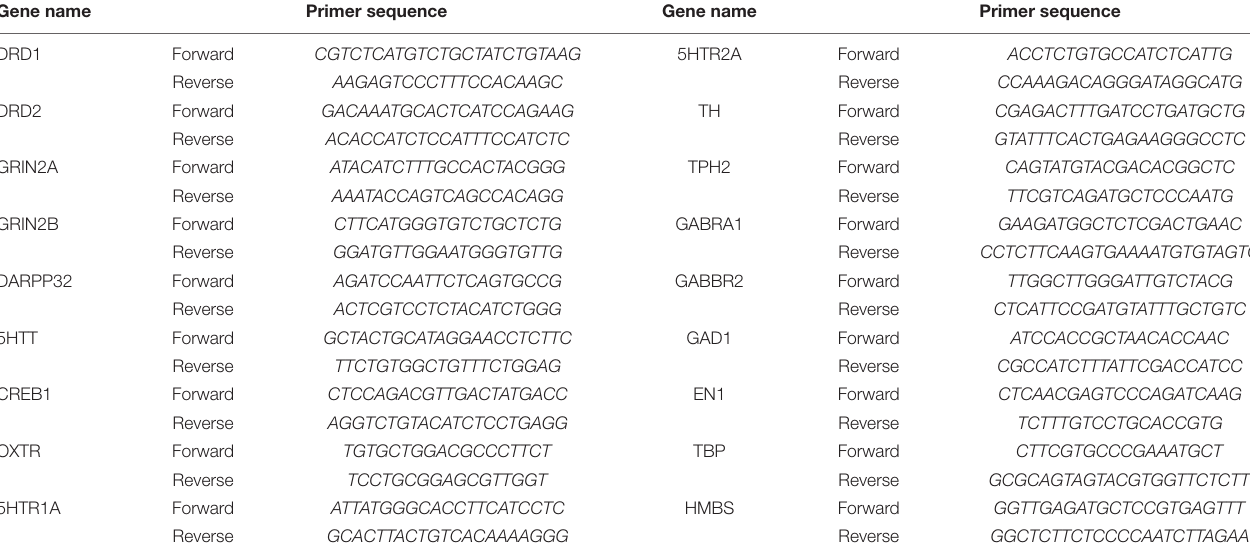
TABLE 1 | Primers used for